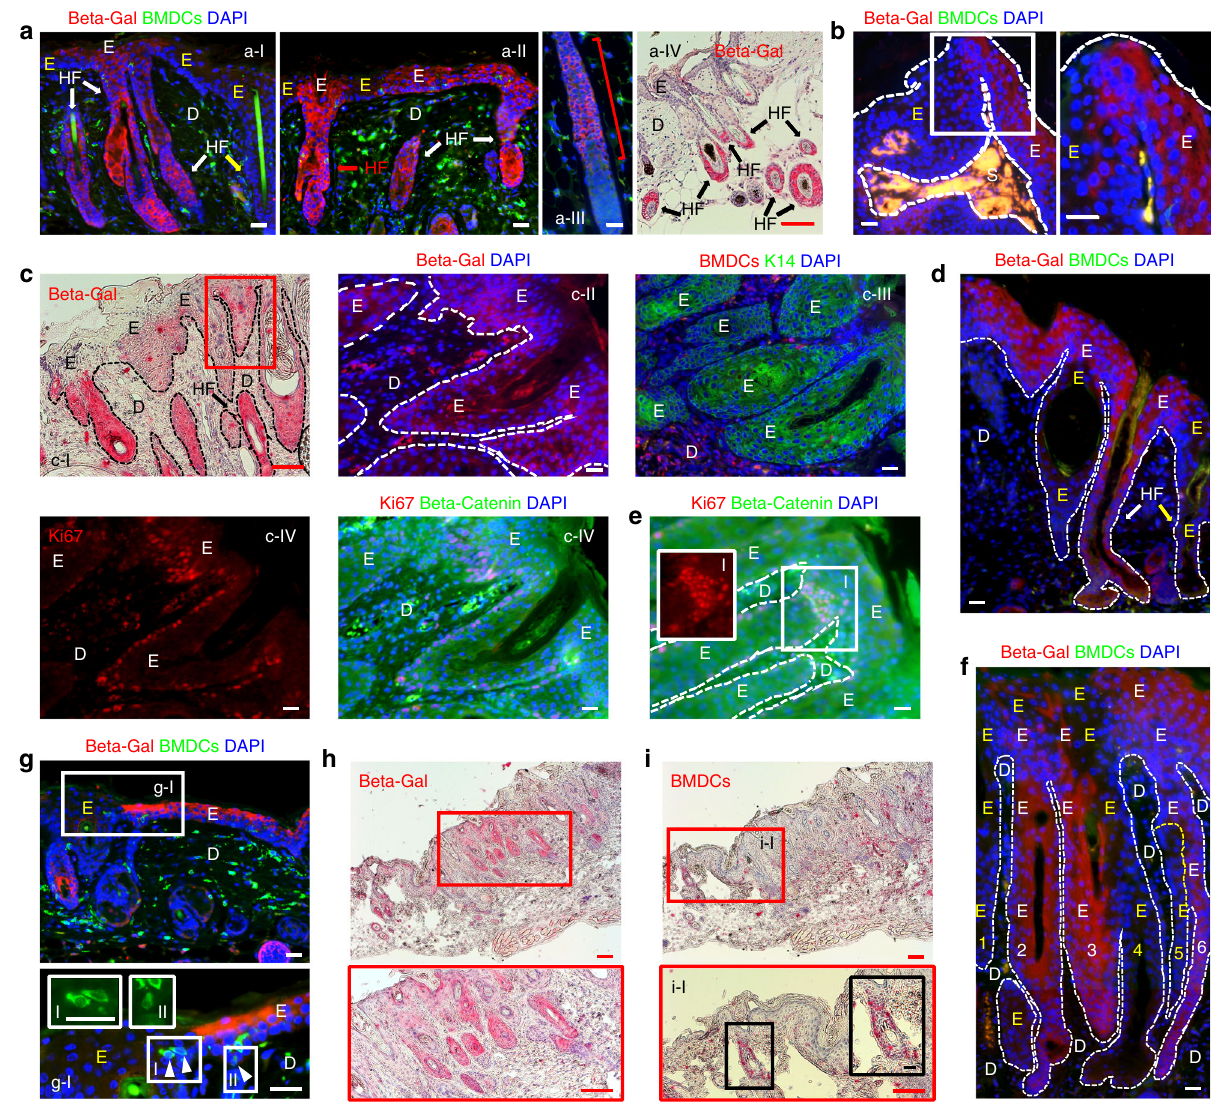
Fig. 6 K15-positive bulge stem cells contribute to development of ulcer-associated dysplasia. a Contribution of K15-positive bulge stem cells (Beta-gal- positive) in hyperplastic epidermis. a-I Beta-gal-positive (white arrows and white E) and negative (yellow arrow and yellow E) HF are identi fi ed. a-II Beta- gal-positive cells are identi fi ed in HFs (red and white arrows) and interfollicular epidermis in hyperplastic epidermis. a-III Beta-gal-positive cells (red line) are identi fi ed in the bulge and lower HF in anagen. a-IV Beta-gal-positive cells (red IHC staining and black arrows) in HF bulge area and lower HF. b Contribution of Beta-gal-positive cells in papilloma epithelium. The junction of Beta-gal-positive and negative area (white box) is magni fi ed. c Contribution of K15 bulge stem cells in dysplasia. c-II-IV Serial sections of red box area in c-I. c-I and c-II Beta-gal-positive cells are mainly located in the HF structure in dysplastic epidermis. c-III Serial sections show beta-gal-positive area is also K14-positive, and (c-IV) cytoplasmic beta-catenin expression with Ki67-positive cells located in basal region. d Beta-gal-positive cells located in both HF (white arrow) and interfollicular epidermis (white E) in dysplastic epidermis. e Ki67- and beta-catenin-expressing cells located in the neck region of dysplastic HF. f Cellular sources from six different dysplastic HFs (three beta-gal-positive, white E ’ s, and three beta-gal-negative, yellow E ’ s) participate in developing dysplastic interfollicular epidermis. g Beta-gal-positive cells (white E) and KC-shaped BMDCs (arrowheads) were observed together in hyperplastic interfollicular epidermis. White box area is magni fi ed. g-I KC-shape BMDCs in white box-I and white box-II are magni fi ed. h , i IHC of serial sections identi fi ed beta-gal-positive cells and BMDCs in close area of dysplastic epidermis. h Beta-gal-positive cells are in dysplastic HFs. Red box area is magni fi ed. i A group of BMDCs were identi fi ed in a HF adjacent to dysplasia. Red box area is magni fi ed. i-I Area of BMDCs is magni fi ed further in black box. *Black and white scale bar, 50 µ m; Red scale bar, 200 µ